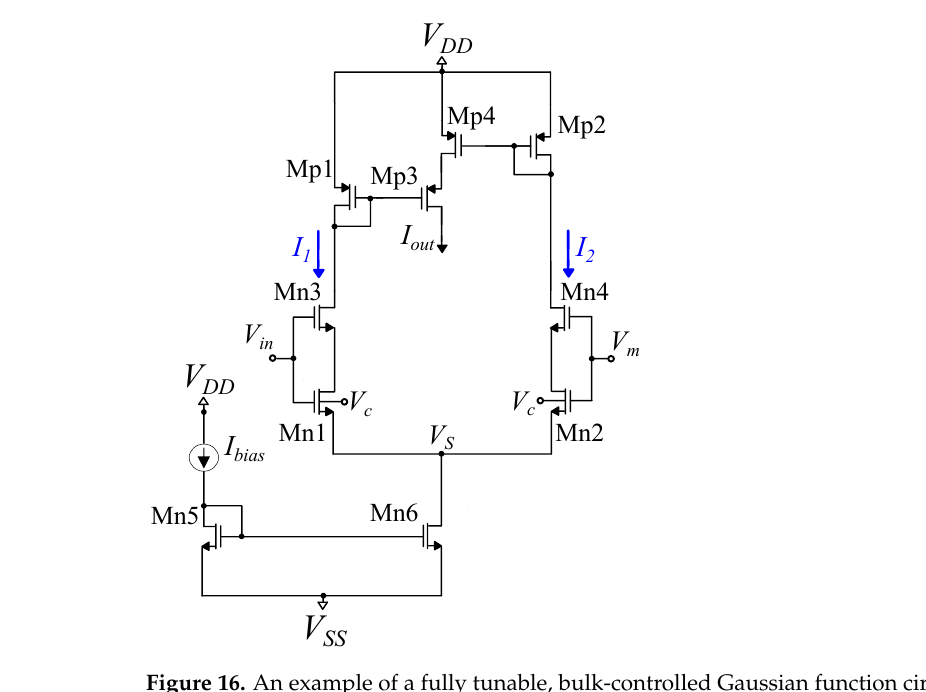
Figure 16. An example of a fully tunable, bulk-controlled Gaussian function circuit.